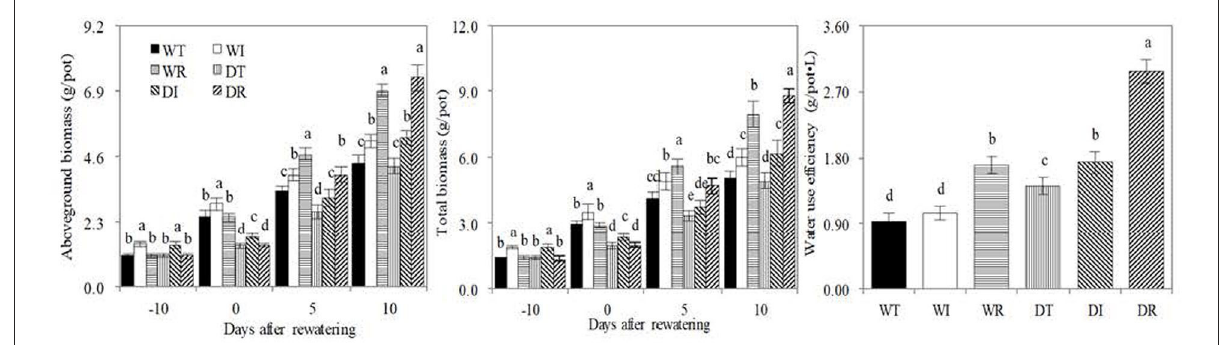
FIGURE4 Biomass, water use efficiency in the different treatments in the study. WT, WI, WR, DT, DI, and DR indicate treatments of wetness, wetness with AOB strain inoculation during wet period, wetness with AOB strain inoculation during rewatering period, post-drought rewatering, post-drought rewatering with AOB strain inoculation during wet period, post-drought rewatering with AOB strain inoculation during rewatering period, respectively. In “ − 10” means the 10th day before the beginning of rewatering, namely the end of the wet period. In “0”, “5”, and “10” respectively stand for the beginning, 5th, 10th days of the 10-day rewatering period. The values are the mean ± standard error ( n = 3). The different letters in each row indicate significant differences ( P <